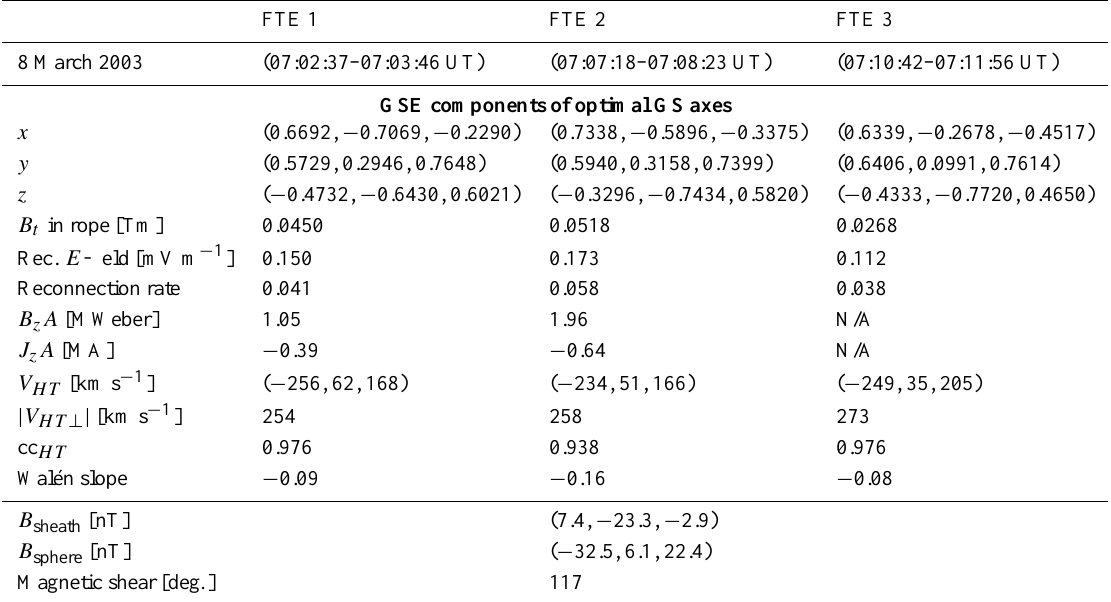
Table 1. Parameters for reconstructed FTEs seen by Cluster on 8 March 2003. FTE 1 FTE 2 FTE